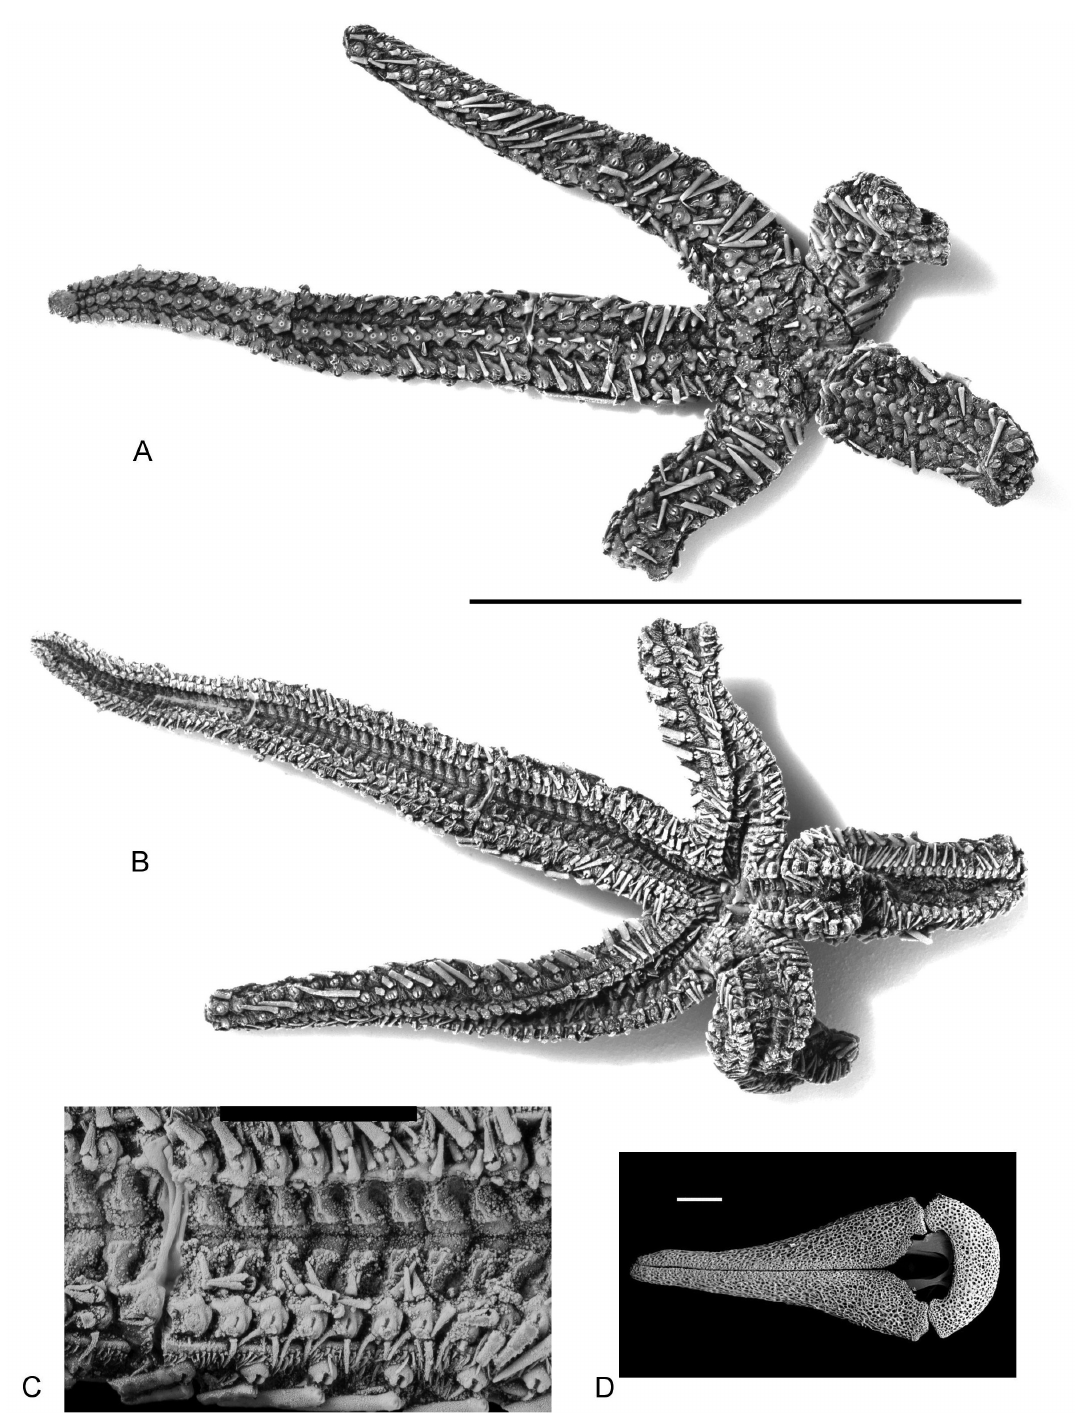
Fig. 16. A–C . Alkaidia sumralli Blake & Reid, 1998 (NHMUK EE15225). A–B . Abactinal (A) and actinal (B) views of well-preserved individual, retaining spines and pedicellariae. C . Enlargement of ambulacral groove, showing spines and duck-bill pedicellariae. — D . Zoroaster fulgens Thomson, 1873, duck-billed pedicellaria of a zoroasterid (A.S. Gale collection, unregistered). Provenance: A–C. Grayson Formation, Graysonites wacoense ammonite Zone, Dottie Lynn Lane, Fort Worth, Texas, USA (for details of locality, reference is made to Hess 2015 and Gale et al. 2021). D. Recent, Rockall Trough, northeast Atlantic. Scale bars: A–B = 50 mm; C = 5 mm; D = 0.5